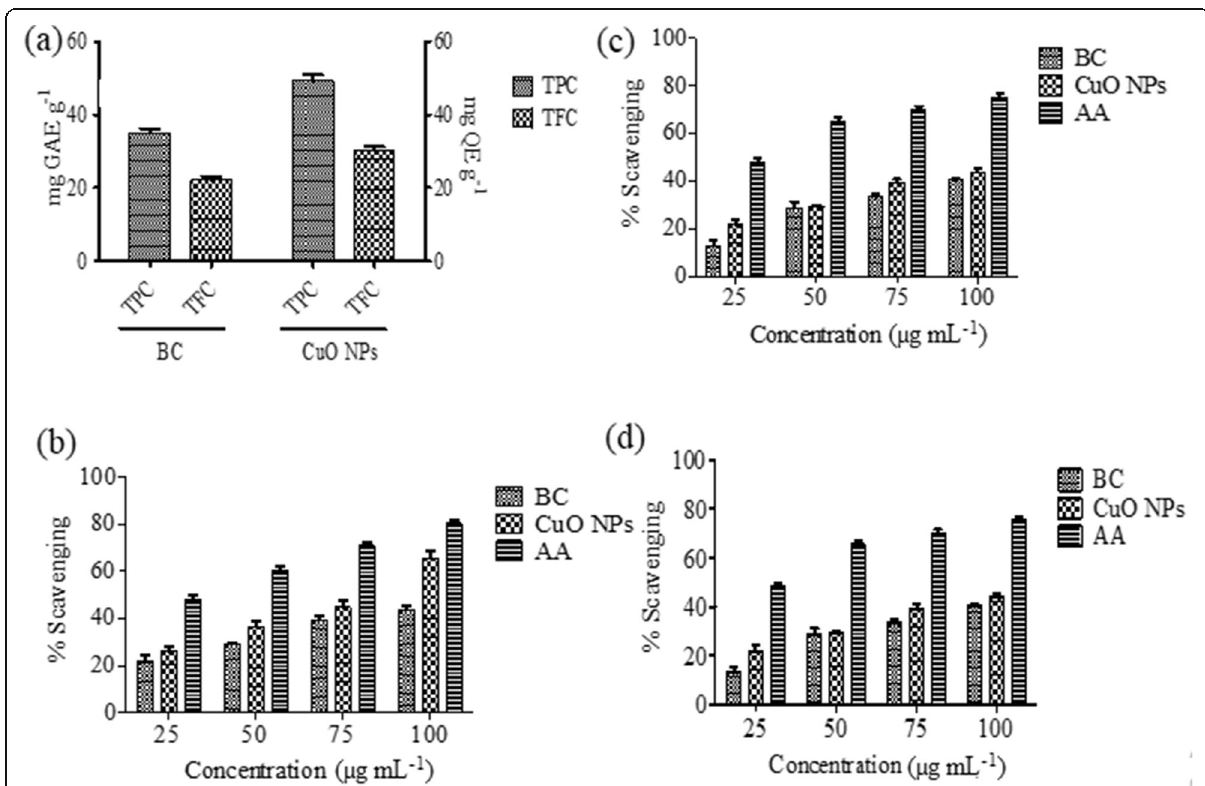
Fig. 7 Biological activity of B. ciliata (BC) and CuO NPs ( a ) TPC and TFC ( b ) DPPH assay ( c ) ABTS assay ( d ) FRAP assay; Values represent mean ± SD of triplicates; TPC = total phenolic content; TFC = total flavonoid content; mg GAE g − 1 DE: mg gallic acid equivalents per gram of dry extract of the sample; mg RE g − 1 DE: mg rutin equivalents per gram of dry extract of the sample